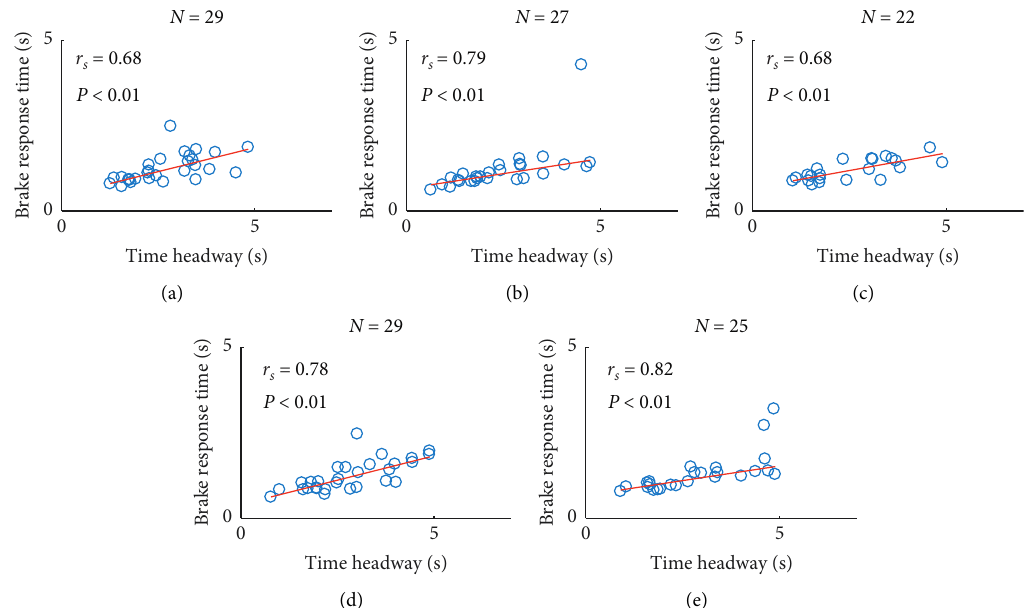
Figure 8: Drivers’ brake response times as a function of time headway, in the second braking scenario. (a) No phone N � 29. (b) Hands-free (simple) N � 27. (c) Hands-free (complex) N � 22. (d) handheld (simple) N � 29. (e) Handheld (complex) N �